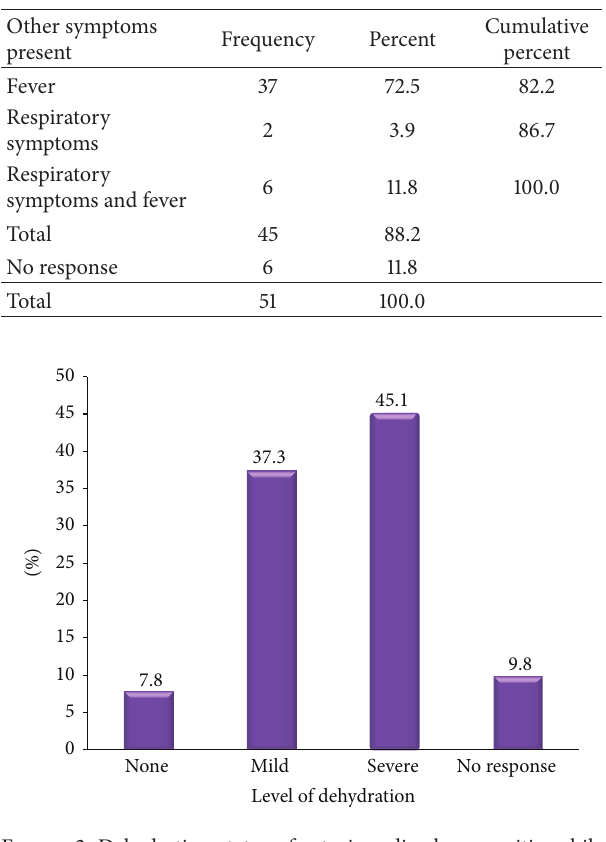
Figure 2: Dehydration status of rotavirus diarrhoea positive chil- dren in